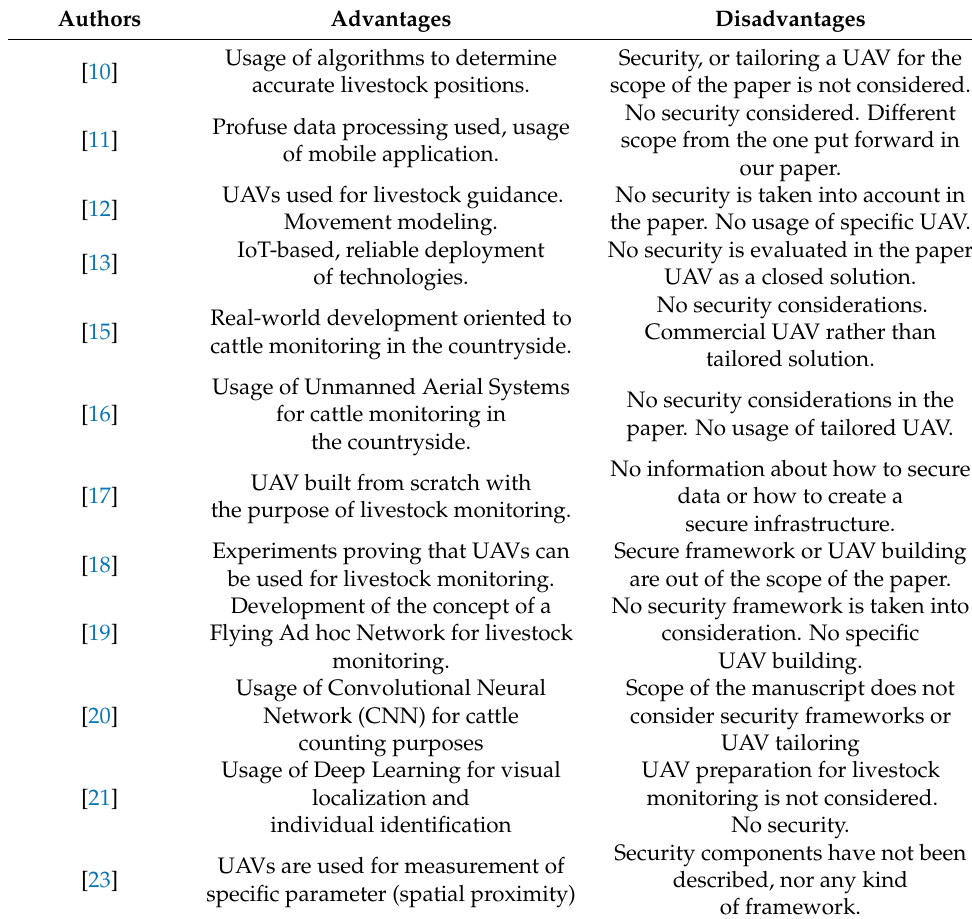
Table 1. Advantages and disadvantages of the studied UAV